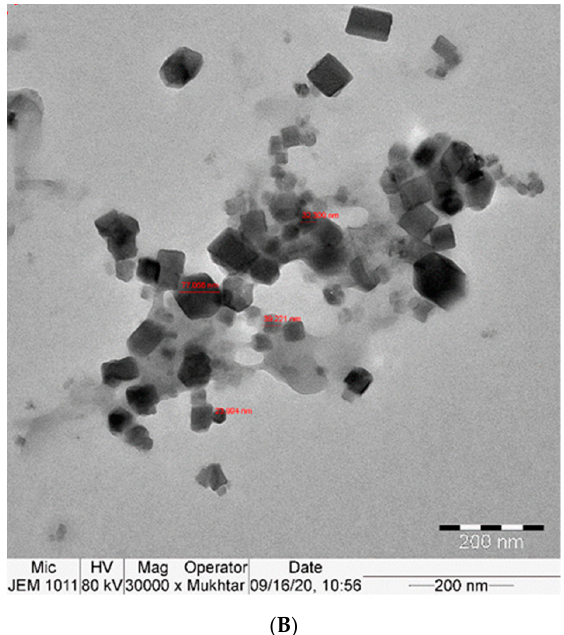
Figure 1. ( A , B ): TEM image of Nano-CURcumin (Nano-CUR) showing particles size 26–78 nm.